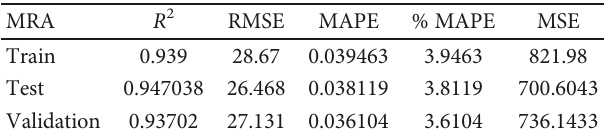
Table 11: MRA error performance